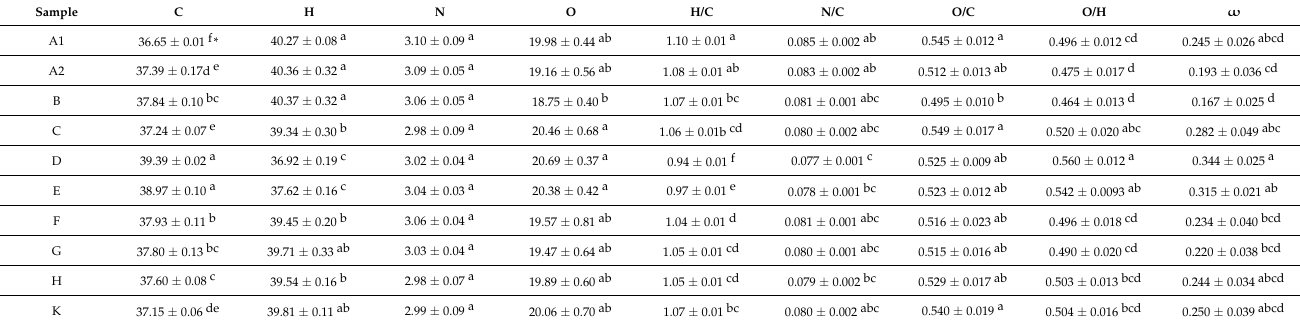
Table 6. Elemental composition and atomic ratio of humic